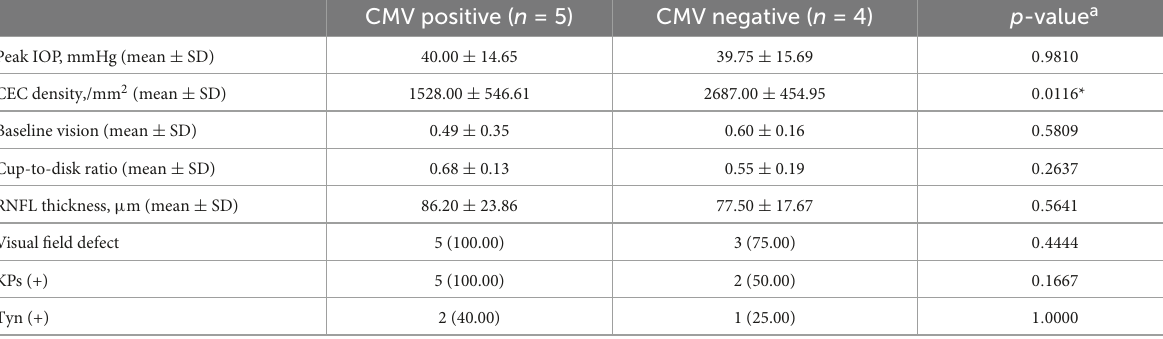
TABLE 2 Demographic and clinical data of patients with